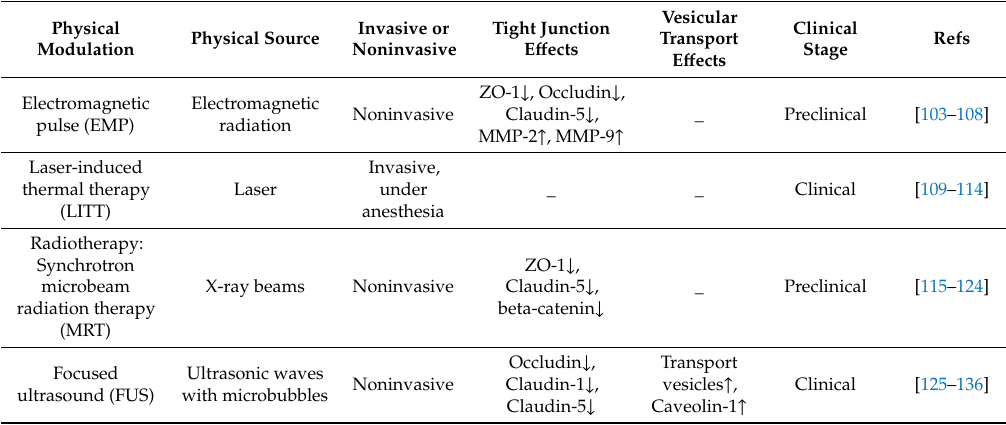
Table 2. Selective physical modulation for circumventing the BBB in treating